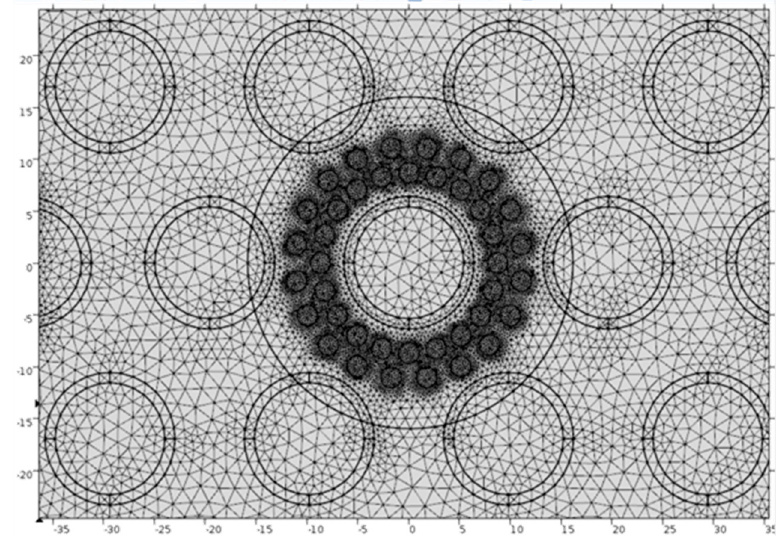
Figure 8. Computational mesh for solving the electric field.